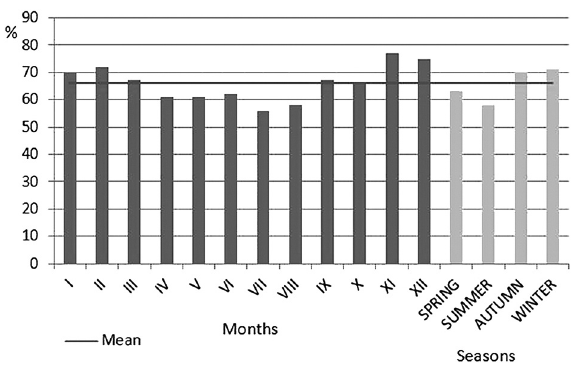
Fig. 1. Mean annual course of cloudiness in